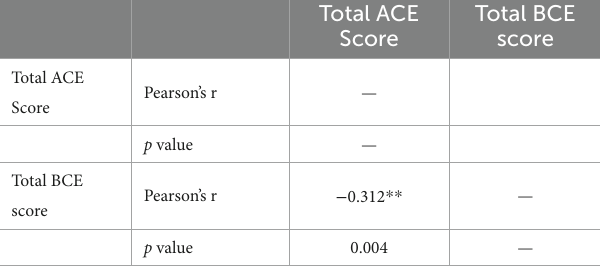
TABLE 7 Qualitative factors which impacted upon T2–T5 psychometric data.